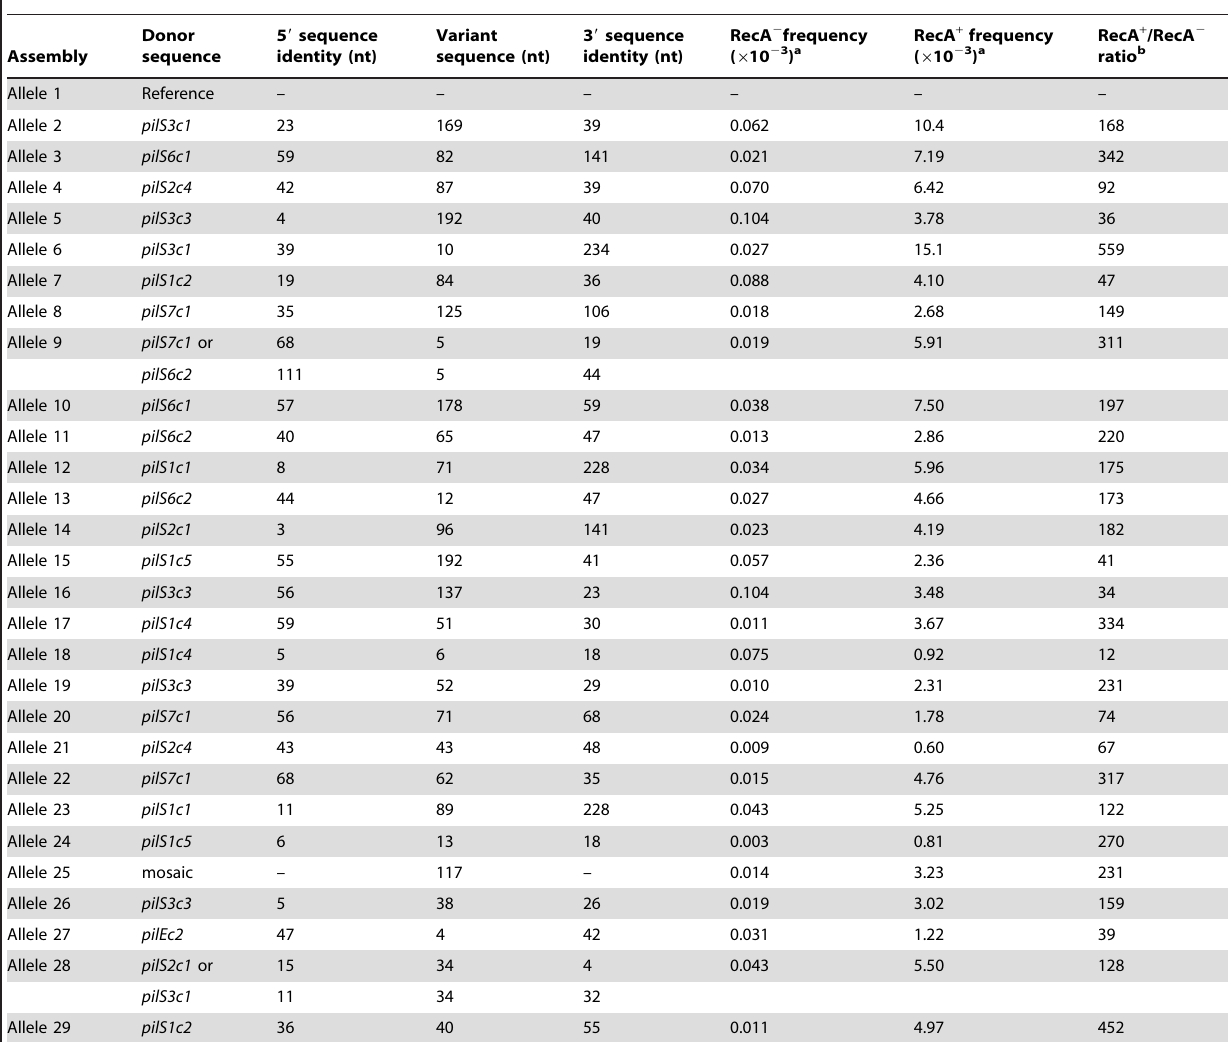
Table 3. Variant sequences detected in the first experiment with pilE from N. gonorrhoeae FA1090.